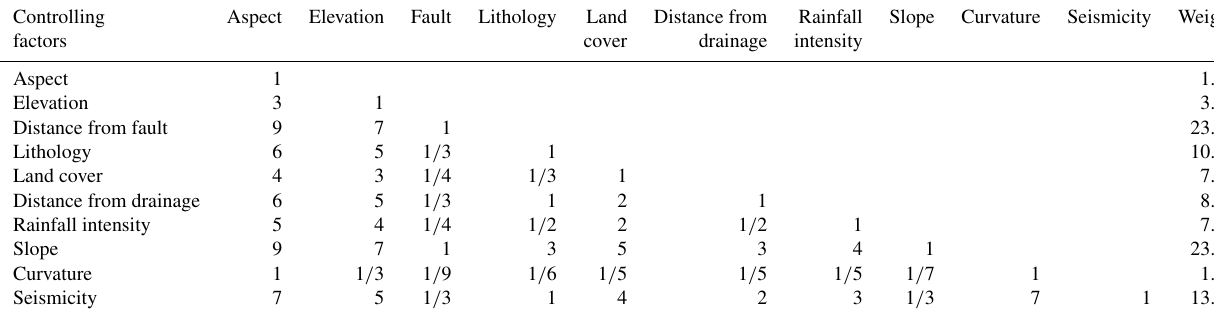
Table 5. Pairwise matrix and weights of all controlling parameters. Controlling Aspect Elevation Fault Lithology Land Distance from Rainfall Slope Curvature Seismicity Weight factors cover drainage intensity Aspect